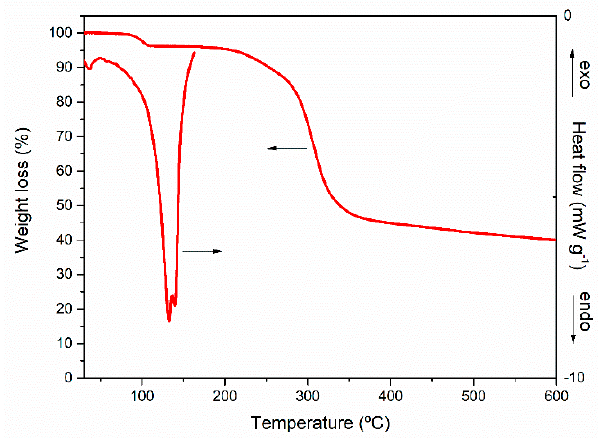
Figure 1. Thermogravimetric analysis (TGA) (left side y axis) and differential scanning calorimetry (DSC) (right side y axis) traces of the [Er(tta) 3 (H 2 O) 2 ] complex.